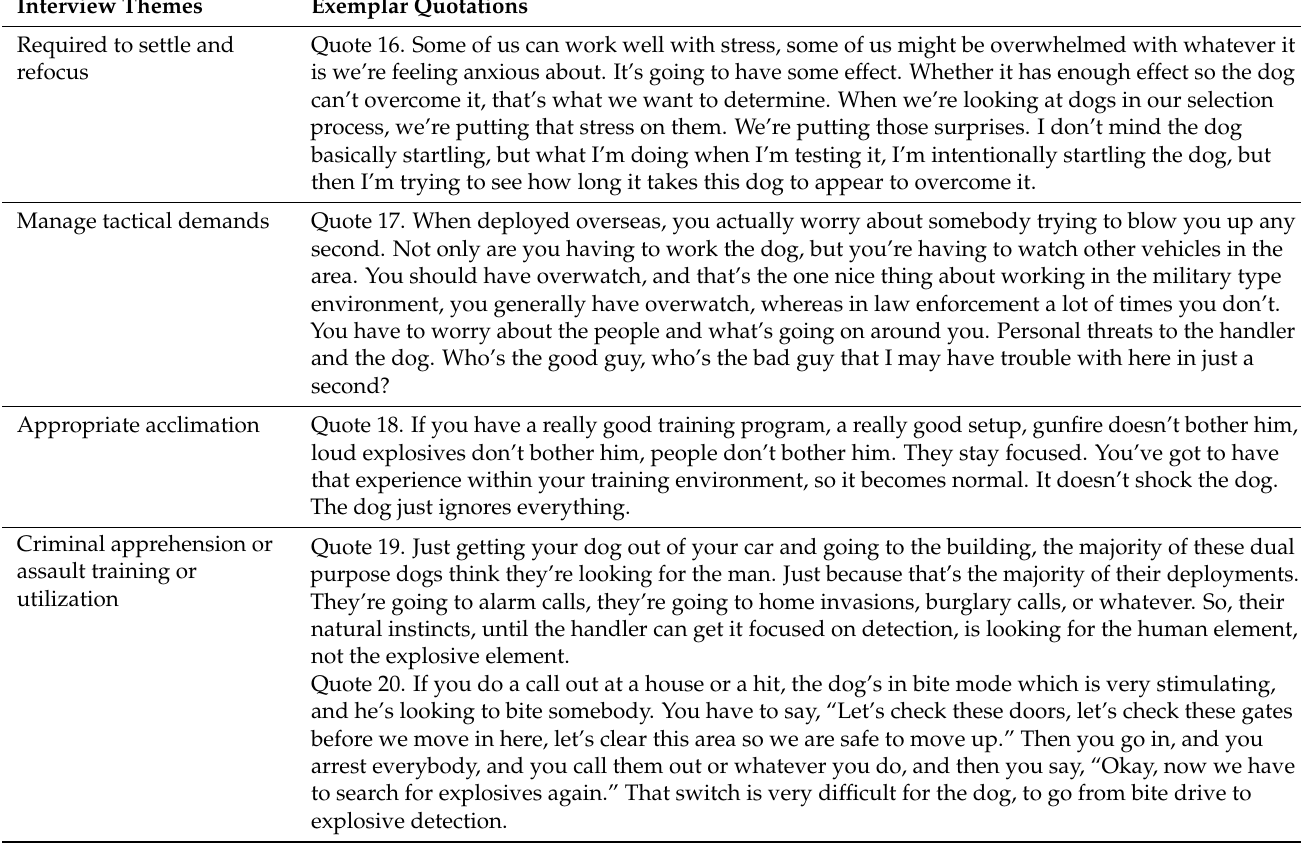
Table 5. Operational environment interview themes and exemplar